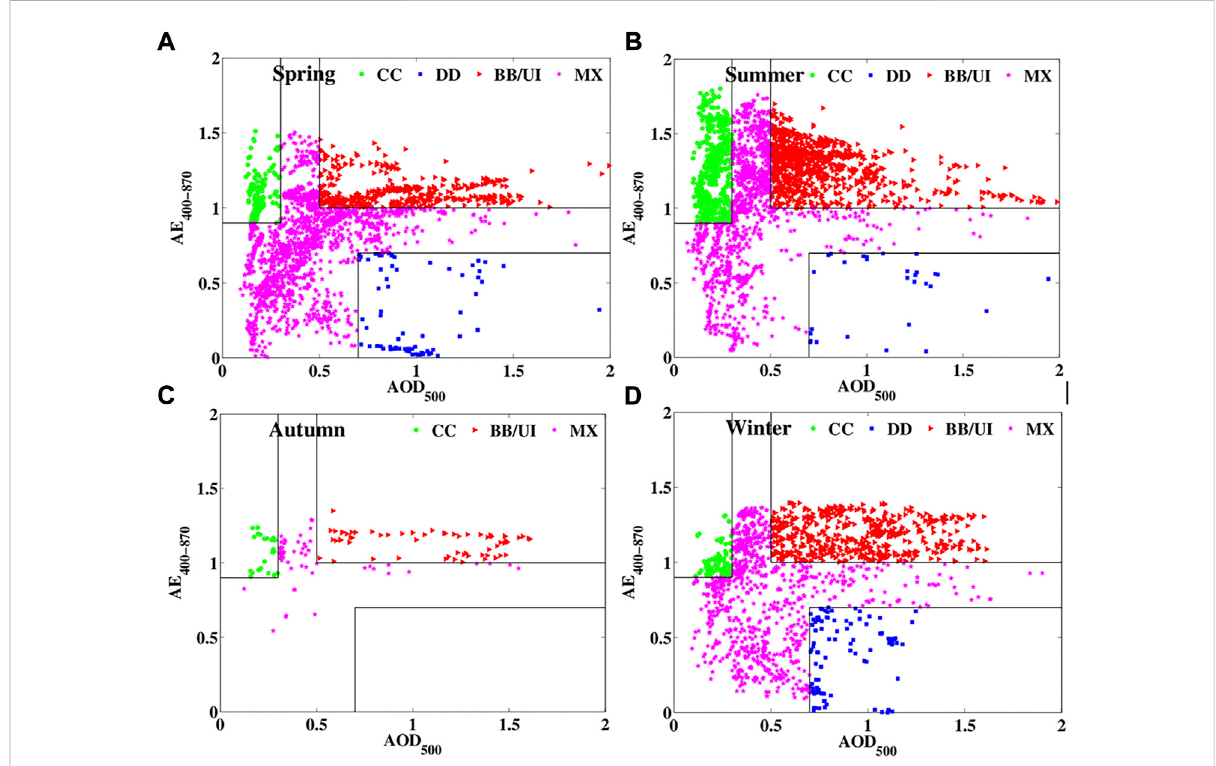
FIGURE 5 Differentaerosoltypes(green:CC;blue:DD;red:BB/UI;purple:MX)werediscrimination basedontherelationshipsofAOD 500 andAE 400-870 in different seasons (Spring (A) , Summer (B) , Autumn (C) , Winter (D) ).